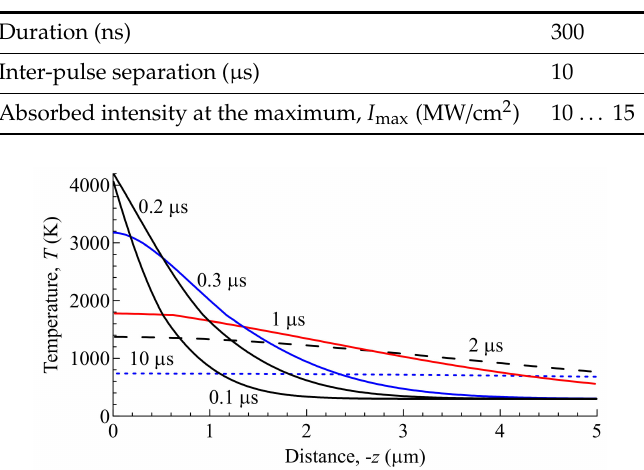
Figure 3. Dynamics of the temperature field in the target for a single pulse with I max = 15 MW / cm 2